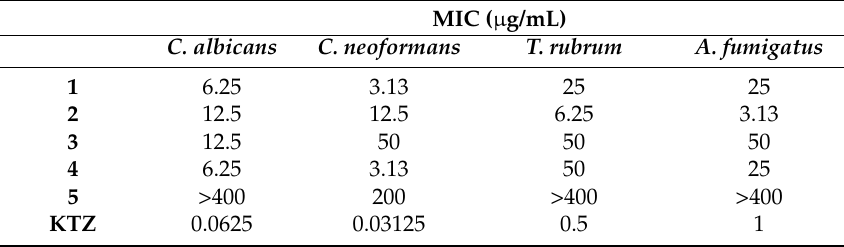
Figure 6. Structures of compounds 1 – 5 . Table 2. Anti-fungal effects of compounds 1 – 5 .